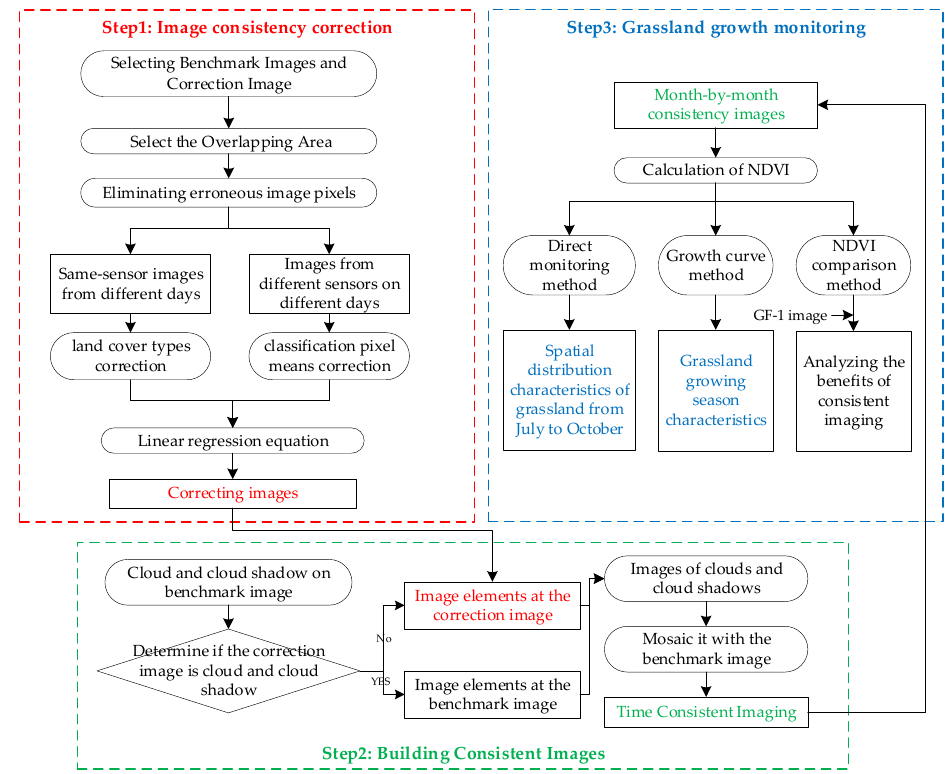
Figure 3. The technical fl ow chart of this